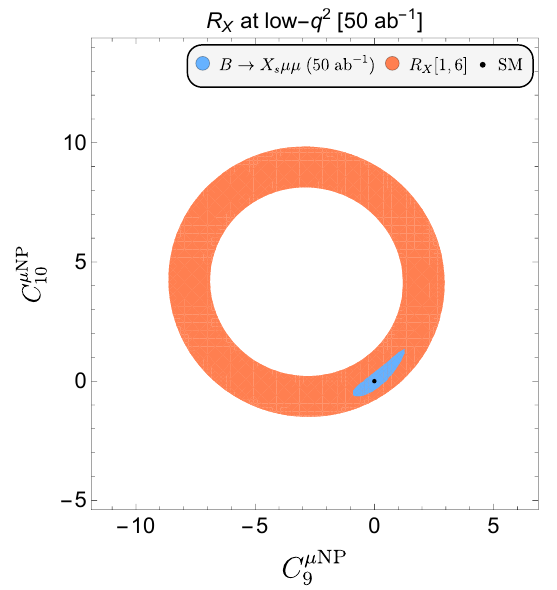
= C e SM . The combined 9 ; 10 9 ; 10